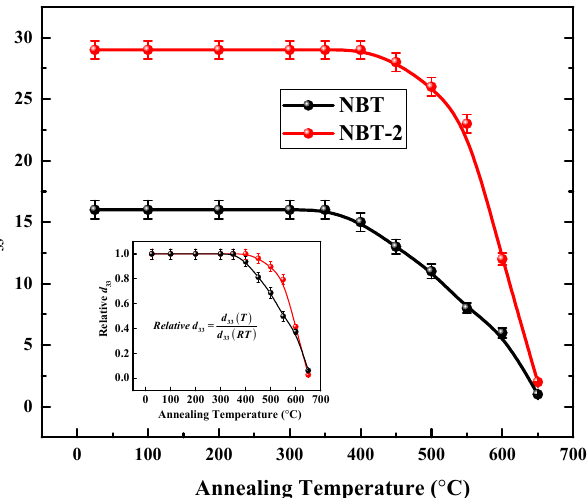
Figure 9. Effect of the thermal annealing on the piezoelectric coefficient d 33 of the NBT and NBT-2 piezoelectric ceramics. piezoelectric